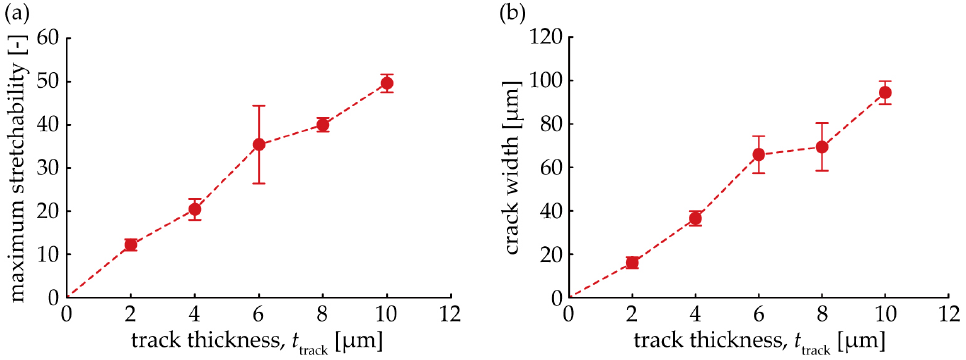
Figure 8. Relationship between the ( a ) maximum stretchability and track thickness; t track , and the ( b ) crack width and track thickness, t track .